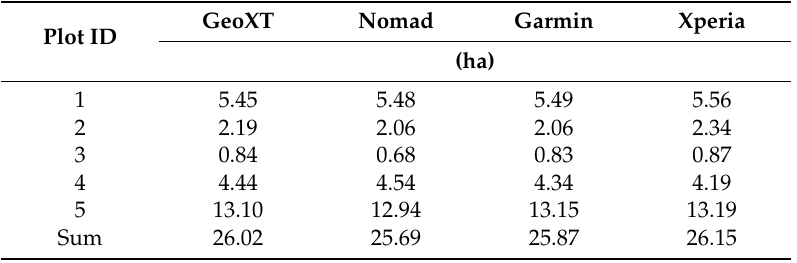
Table 5. Summary of windthrow areas mapped by the four different GNSS devices.